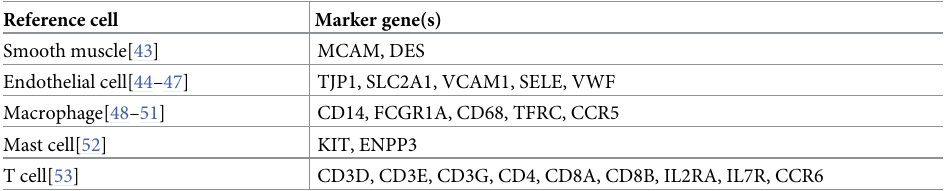
Table 2. Gene markers for each cell type used in population specific expression analysis. Reference